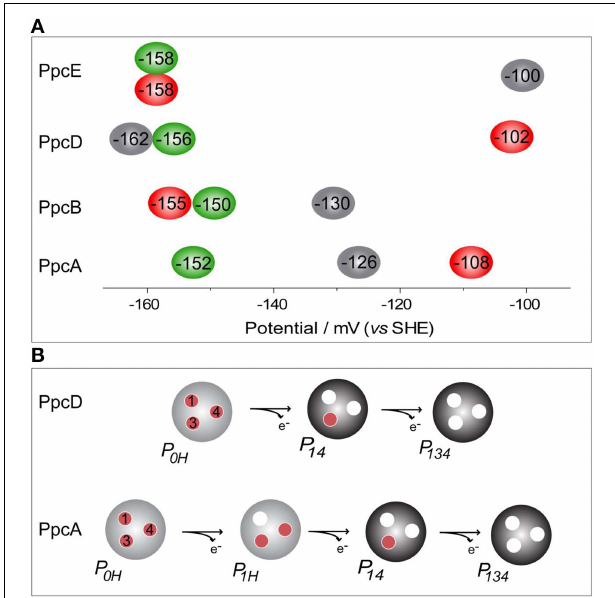
FIGURE 6 | Heme reduction potentials of PpcA, PpcB, PpcD and PpcE (A) and dominant microstates responsible for preferred e − /H + transfer pathways observed for PpcA and PpcD (B). In (A) the hemes I, III, and IV are colored in green, red and black, respectively. Microstates in (B) are labeled as described in Figure 3 .